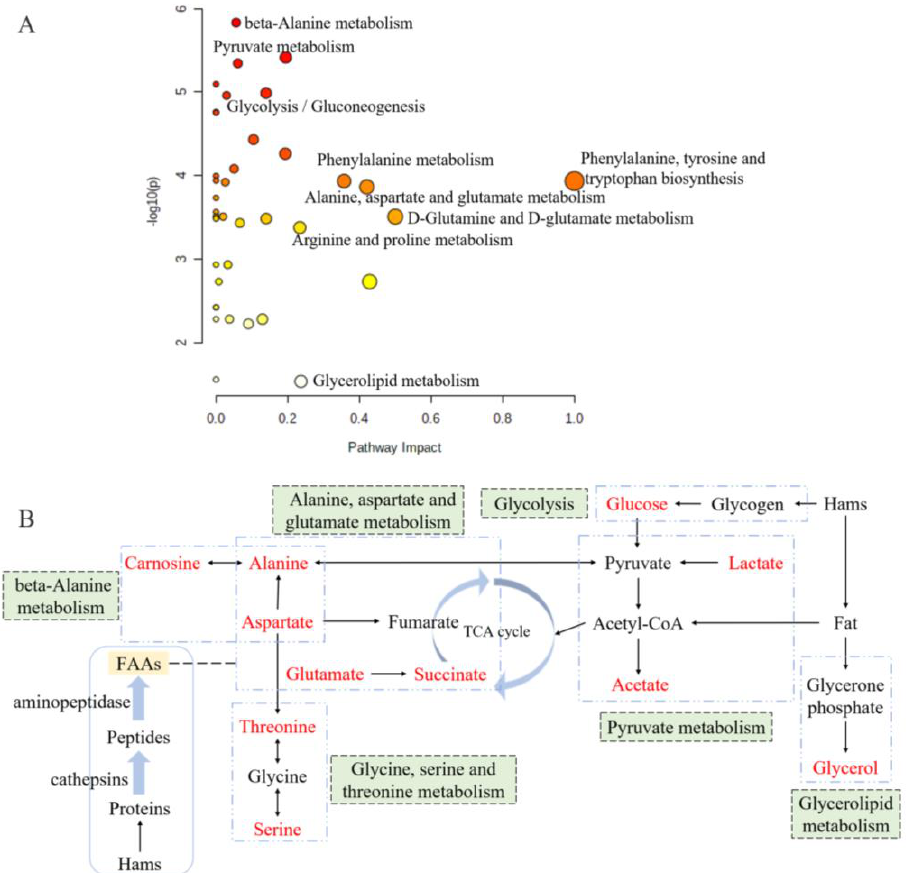
Figure 6. Overview of pathway analysis for significantly differential metabolites ( A ) and the metabolic pathway network related to the key taste compounds ( B ) based on KEGG. The size and color of each circle is based on metabolic pathway impact value and p value. Metabolites in red represent the key taste compounds in this